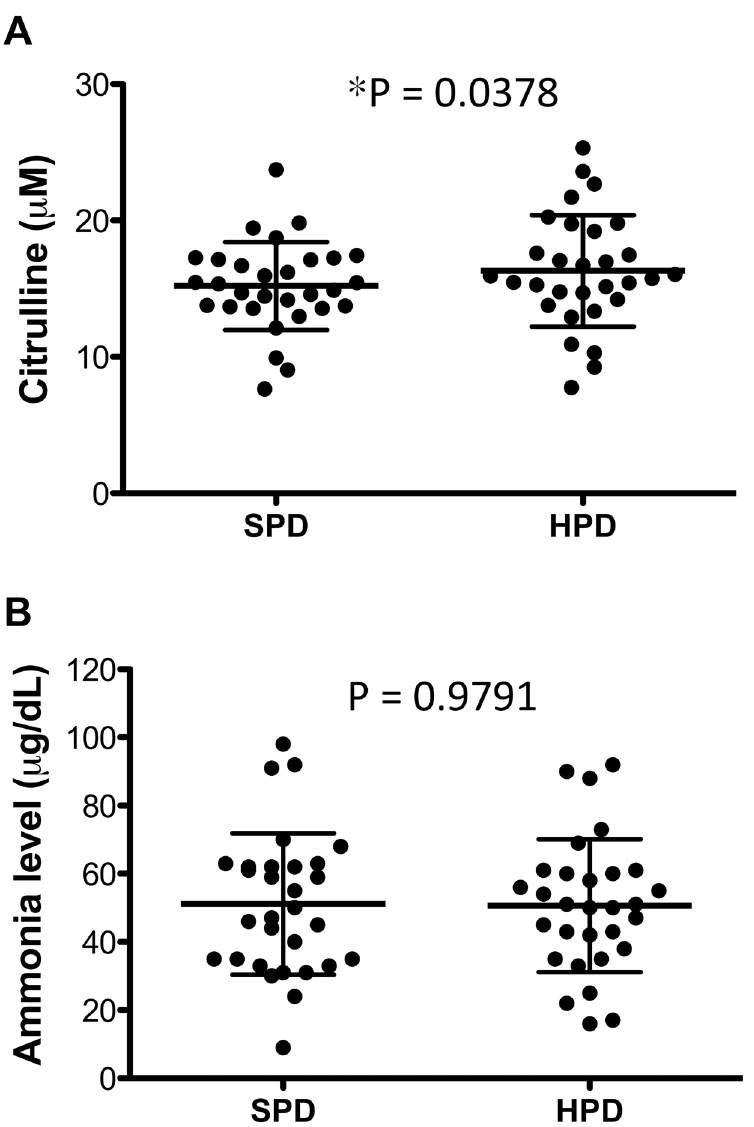
Fig 1. Influence of dietary protein content on the urea cycle in Huntington ’ s disease (HD) patients. Blood citrulline (A) and ammonia (B) levels in HD patients given the standard protein diet (13.7%) and high protein diet (26.3%). The data for the 23 non-HD subjects (Con) were taken from a previous report [13]. All HD patient data were plotted. Data are presented as mean ± standard deviation (SD) and were analyzed by paired t test. * p <